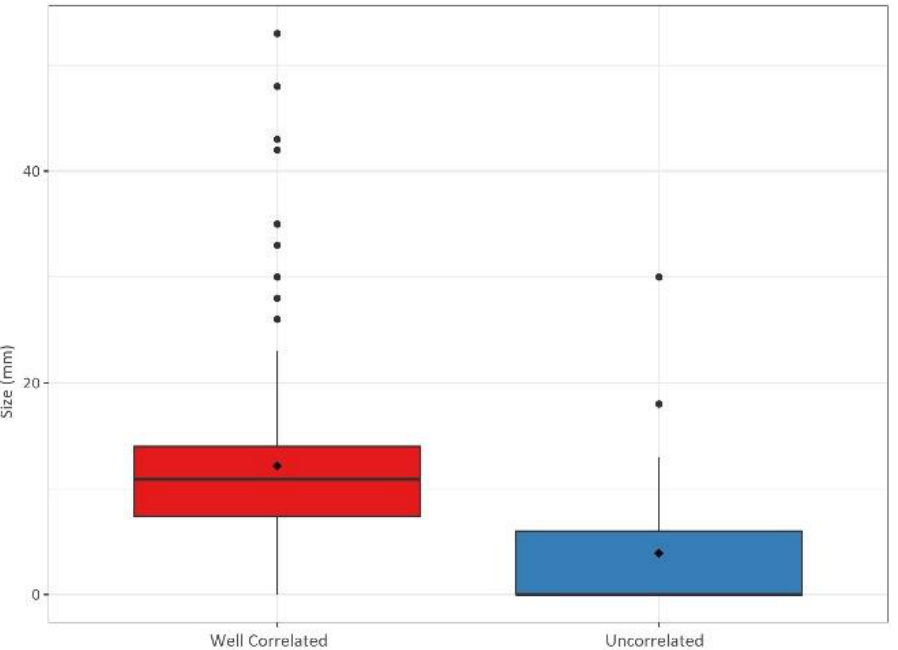
Figure 4. Gland sizes (in mm) in the well-correlated group ( n = 220) and uncorrelated group ( n = 49).